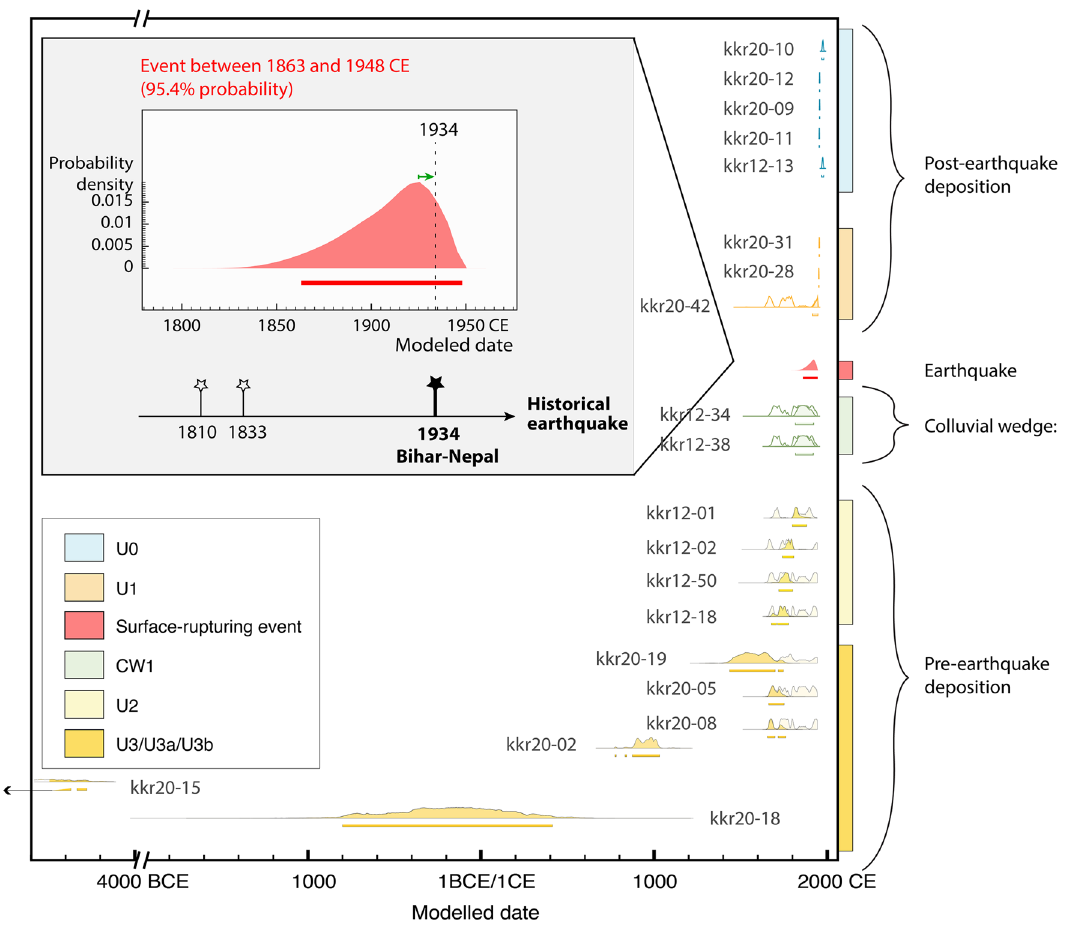
Figure 6. Oxcal chronostratigraphic sequence of the detrital charcoals built from their stratigraphic information. In this model we consider that reworking, inbuilt ages for charcoal samples (i.e., age of the wood at the time of burning) and transport time before deposition are negligible. Detrital charcoal radiocarbon ages are calculated using Oxcal 4.2.4 39 chronostratigraphic models with IntCal13 atmospheric calibration curve 40 . Light and dark grey probability spectra, respectively, indicate the individually calibrated and modelled ages. Red probability spectra indicate the modelled ages for earthquake E1 estimated to fall between 1863 and